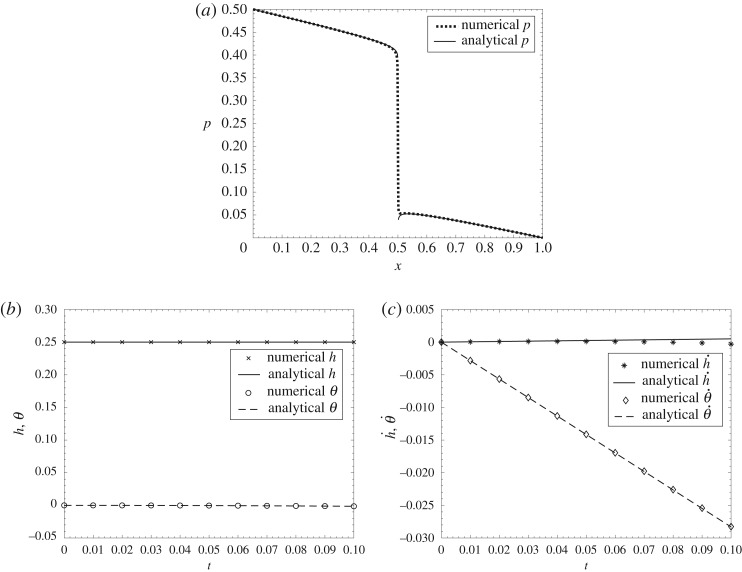
Comparison between small-time analytical solutions and numerical solutions for M^=1, g^=0.24 at early times (a) pressure at time t = 0 + , (b) h and θ against t, (c) h˙ and
θ˙ against t.